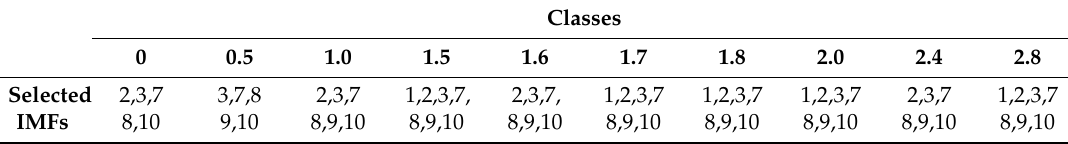
- - - - 0.23 - - - Table 4. The subsets of selected IMFs obtained using the proposed IMF selection procedure.